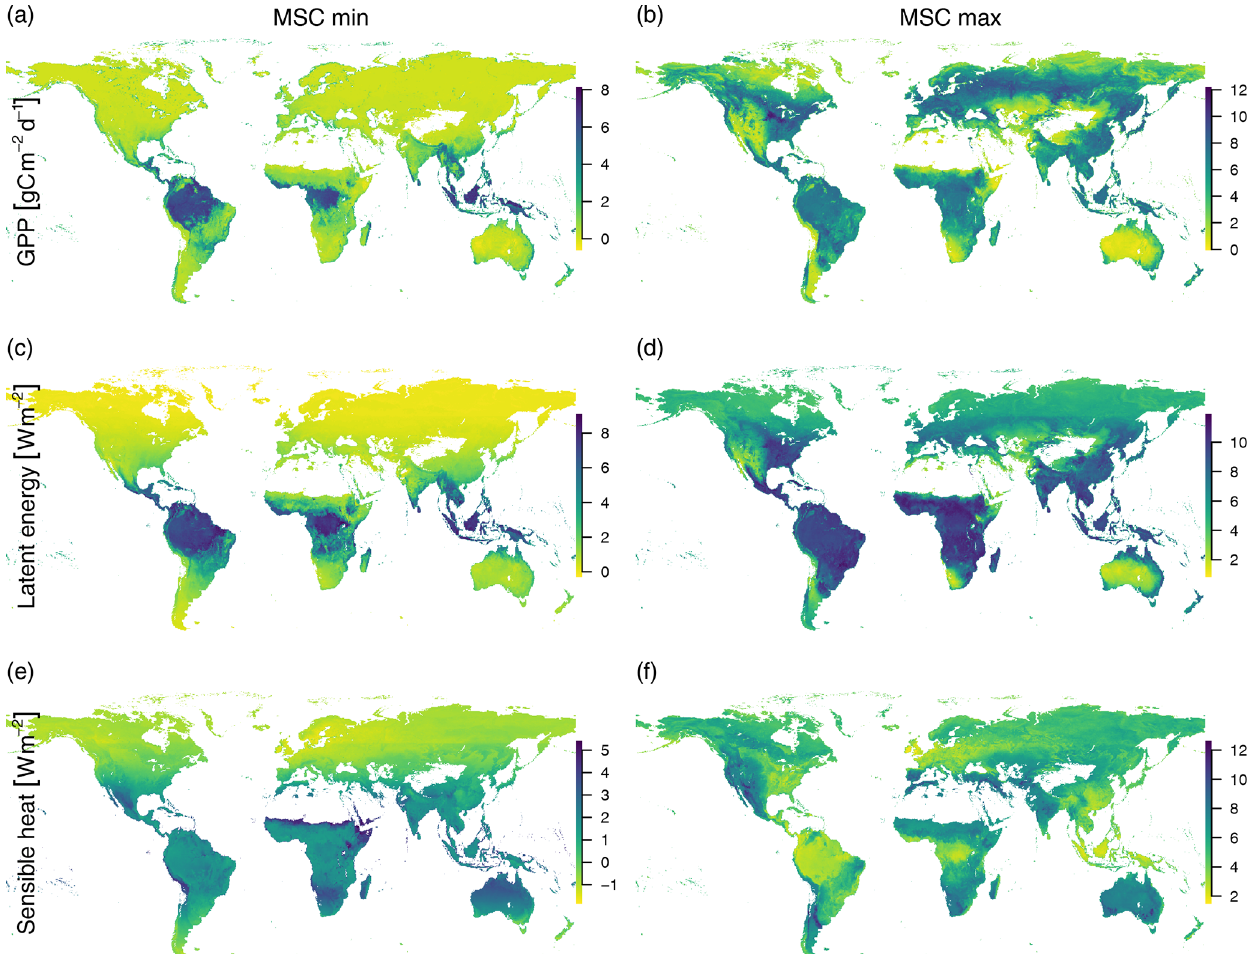
Figure C1. The minimum (a, c, e) and maximum (b, d, f) mean sea- sonal cycles of GPP (a, b) , latent heat (c, d) , and sensible heat (e, f) . This illustrates the similarity of possibly very different ecosystems in terms of productivity and limitations. During peak growing sea- son, many midlatitude areas have a similar productivity and latent energy release as tropical rain forests (b, d) . The highest maximum seasonal sensible heat loss can be found in dry areas around the world and is lowest in areas with a wet climate such as tropical rain forests and maritime climates (f)